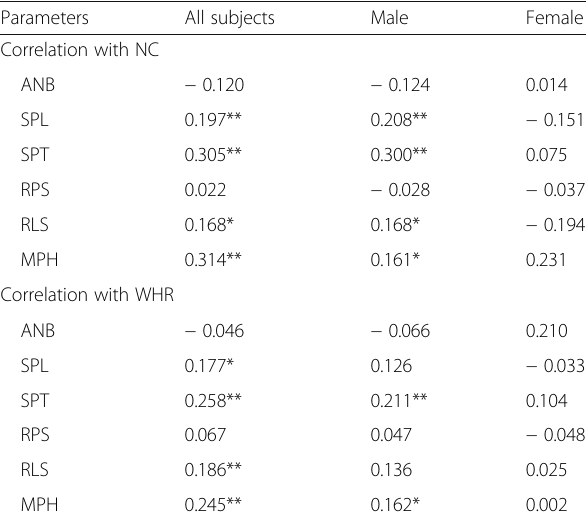
Table 4 Effect of central obesity (anthropometry) on the upper airway anatomy (cephalometry)